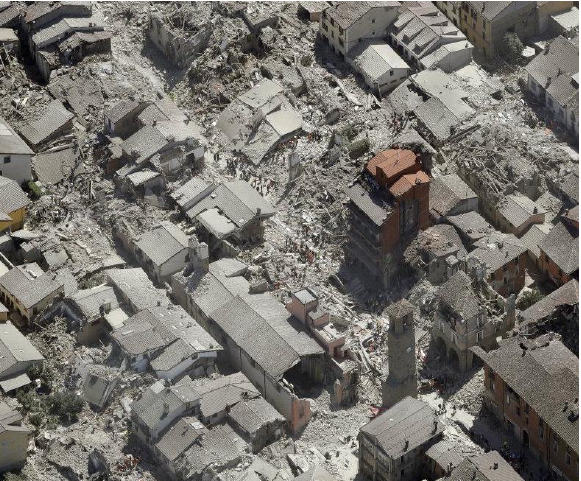
Figure 3. Amatrice (Rieti) after 2016